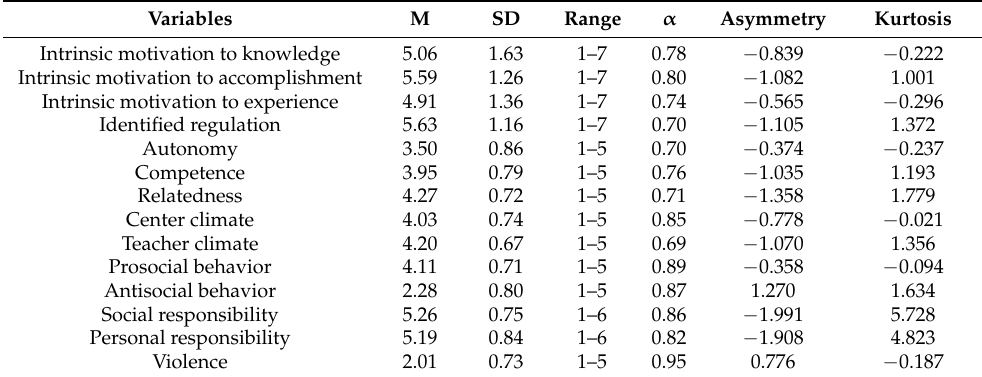
Table 1. Descriptive values.